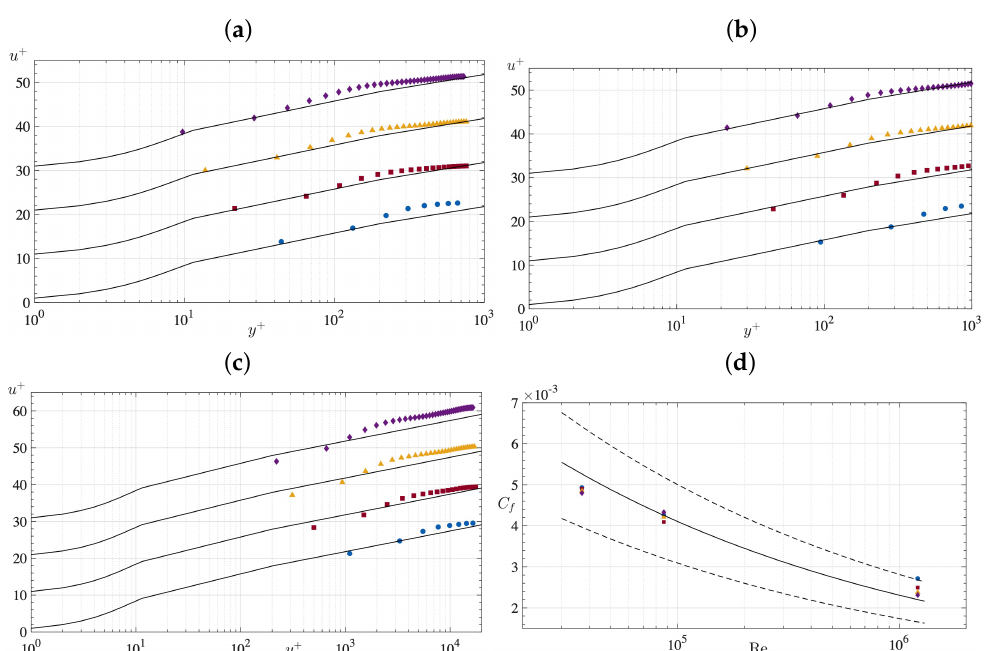
Figure 3. Results (symbols) of turbulent channel flow simulations. ( a – c ) Semi-log plots of mean scaled velocity u + = ˜ u / u τ as a function of the distance y + from one plate, for a half-channel, computed using the pLBM-LES with a wall model, for Re m = ( a ) 37,042, ( b ) 87,000, and ( c ) 1.21 × 10 6 , with a grid resolution N = ( • ) 10, ( (cid:4) ) 20, ( (cid:78) ) 30, and N = 40 ( (cid:7) ). Musker’s profile [35] (——) is shown for comparison. Note, for clarity, results for N = 20, 30, and 40 were shifted by ∆ u + = 10, 20, and 30, respectively. ( d ) Friction coefficient C f on the plates as a function of Reynolds number, computed with the pLBM (symbols), compared to [39]’s experimental data: mean (——) and upper/lower bounds (- - - -).